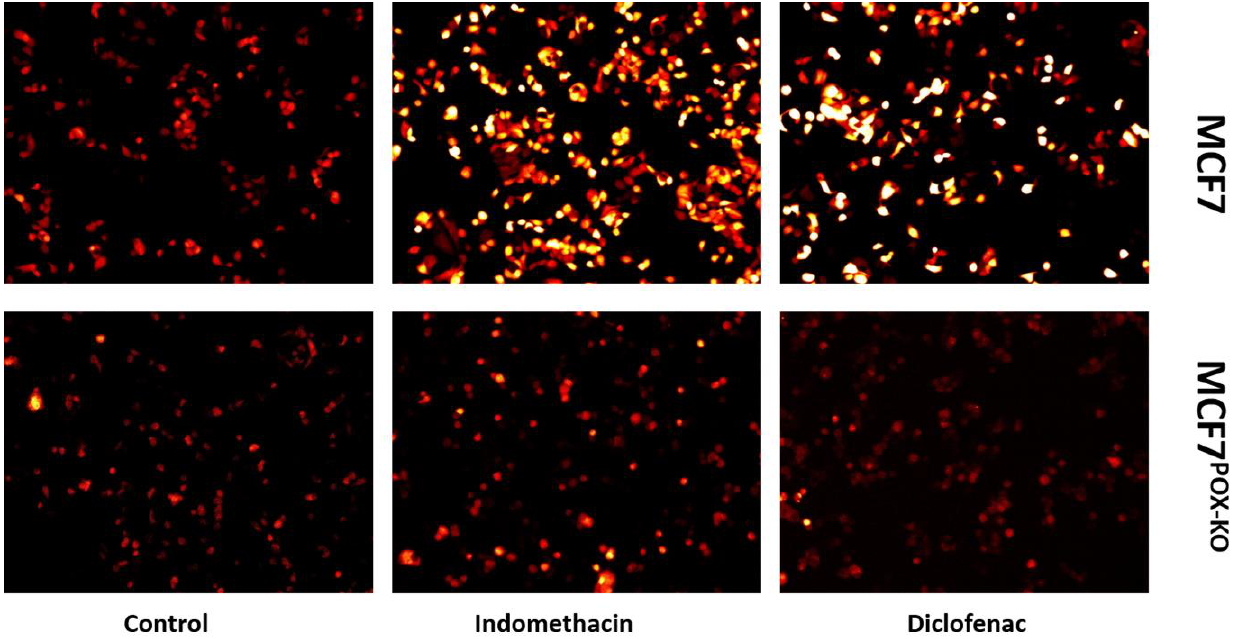
Figure 3. Fluorescence analysis of reactive oxygen species generation using 0.5 µ M of 2 (cid:48) ,7 (cid:48) - dichlorofluorescin diacetate staining. Analysis was performed on live cells using a survival chamber at − 37 ◦ C in 5% CO 2 . MCF7 and MCF7 POX-KO cells were incubated with 0.5 mM indomethacin and 0.375 mM diclofenac for 4 h. Red fluorescence intensity represents amount of generated